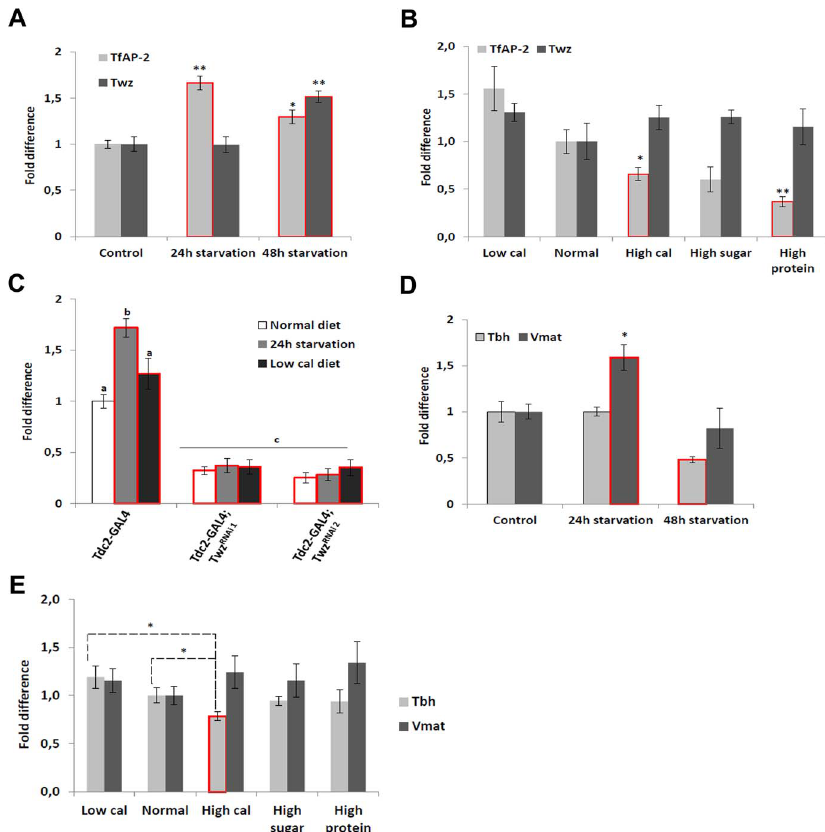
Figure 1. Diet regulates TfAP-2 and Twz transcript levels. (A) Relative levels of Tfap-2 or Twz transcript in the heads of flies starved either for 24 or 48 h. (B) Relative levels of Tfap-2 or Twz transcript in the heads of flies kept on various diets for 5 days. (A–B) RNA was collected from the heads of 50, 5–7 day old, males for each genotype. qPCR was repeated at least 7 times for each transcript. (C) Relative levels of Tfap-2 transcript in the heads of control and Twz knockdown flies starved either for 24 h or kept on a low calorie diet (2.5 g ? dl 2 1 :2.5 g ? dl 2 1 sucrose:brewer’s yeast) for 5 days. RNA was collected from the heads of 50, 5–7 day old, males for each genotype. qPCR was repeated at least 7 times for each transcript. (D) Relative levels of Tbh or Vmat transcript in the heads of flies starved either for 24 or 48 h. (E) Relative levels of Tbh or Vmat transcript in the heads of flies kept on various diets for 5 days. (For all assays n=10 qPCR runs; Different letters indicate similar groups (i.e. ‘a’ is significantly different than ‘b’ or ‘c’ and so on, one-way ANOVA with Bonferroni post hoc test for multiple comparisons, P , 0.05). A single asterisk indicates significant difference in two-way ANOVA, P , 0.05, while a double asterisk indicates significant difference in two-way ANOVA, P , 0.005). Error bars represent the SE (SEM).